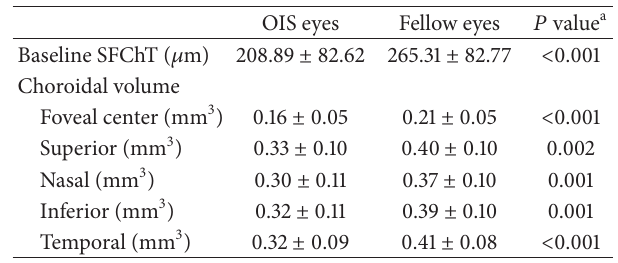
Table 1: Clinical characteristics of unilateral ocular ischemic syn- drome.